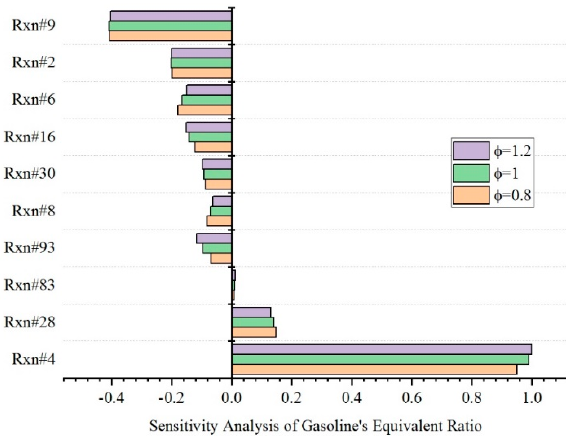
Figure 7. Sensitivity analysis of gasoline under different equivalence ratios.